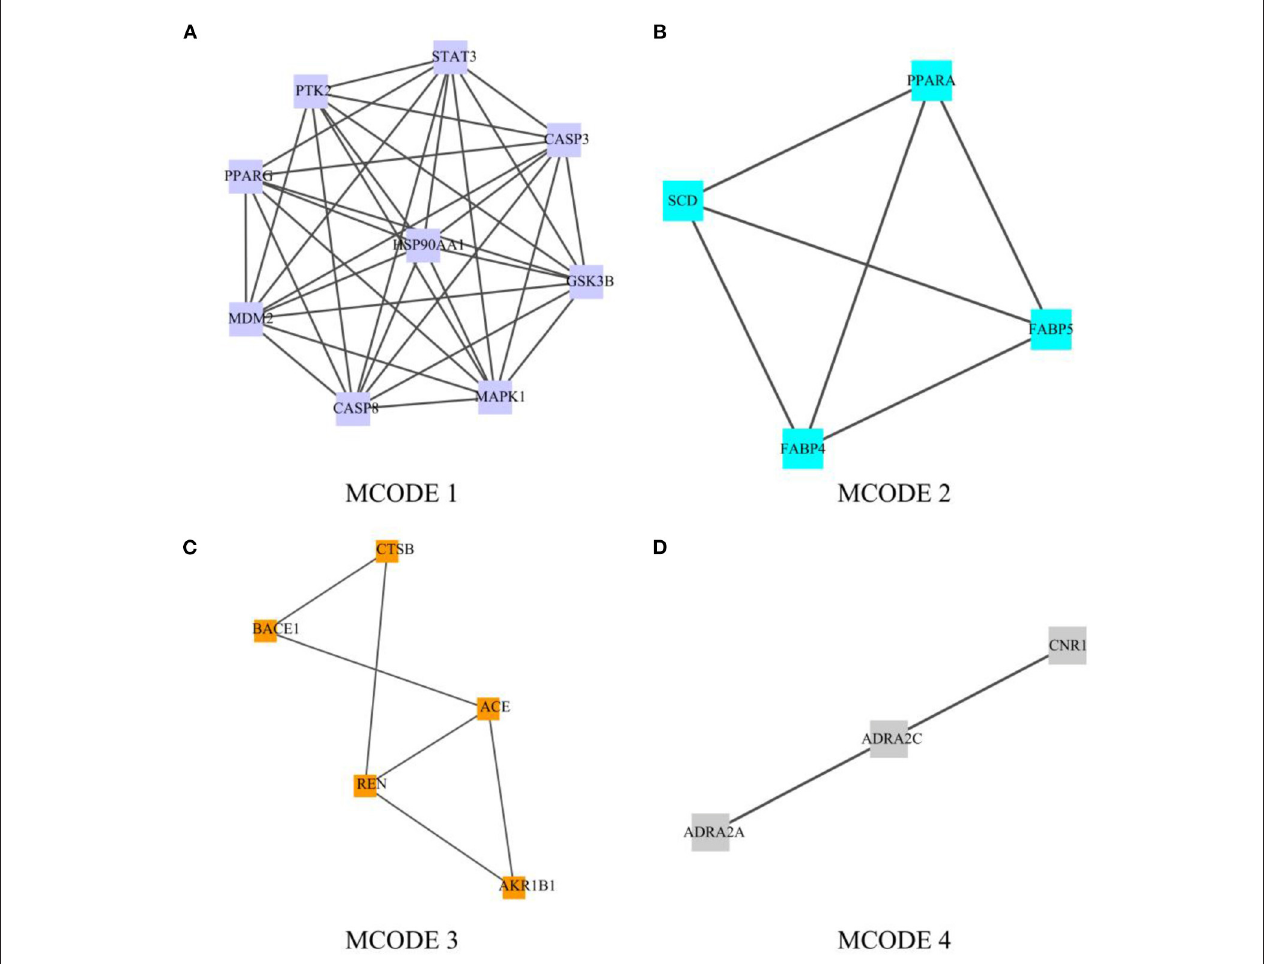
FIGURE 4 | Module-based network analysis of potential targets of Palovarotene against heterotopic ossification. (A–D) Different functional modules in targets of Palovarotene against heterotopic